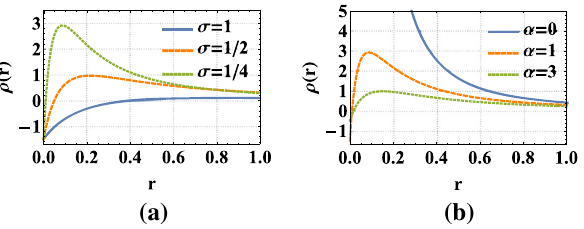
Fig. 8 The string energy density (69) at the limit D → 4. a The string energy density for different spacetime geometries with α = 1. b The string energy density for different GB coupling constants with σ = 1 / 4